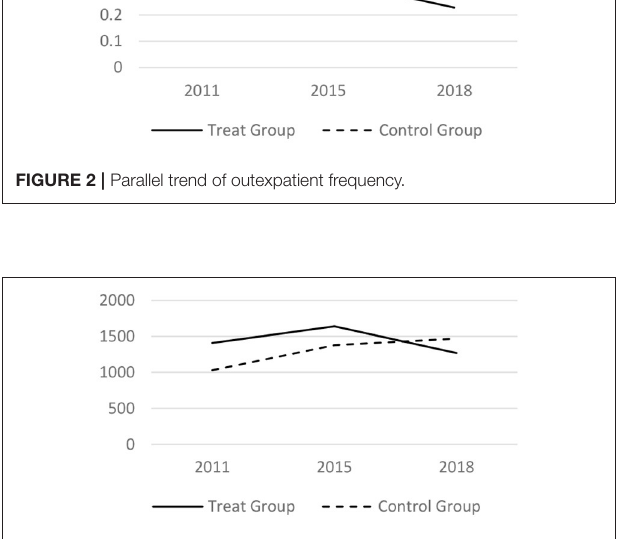
FIGURE 3 | Parallel trend of inexpatient expenses (Yuan).